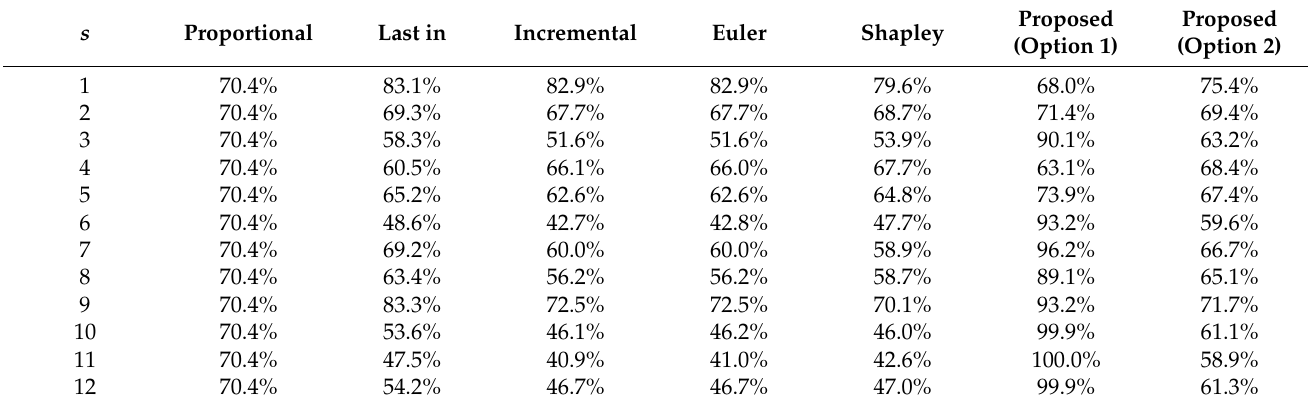
Table 7. Percentage of final capital allocated to each segment (with respect to its initial required